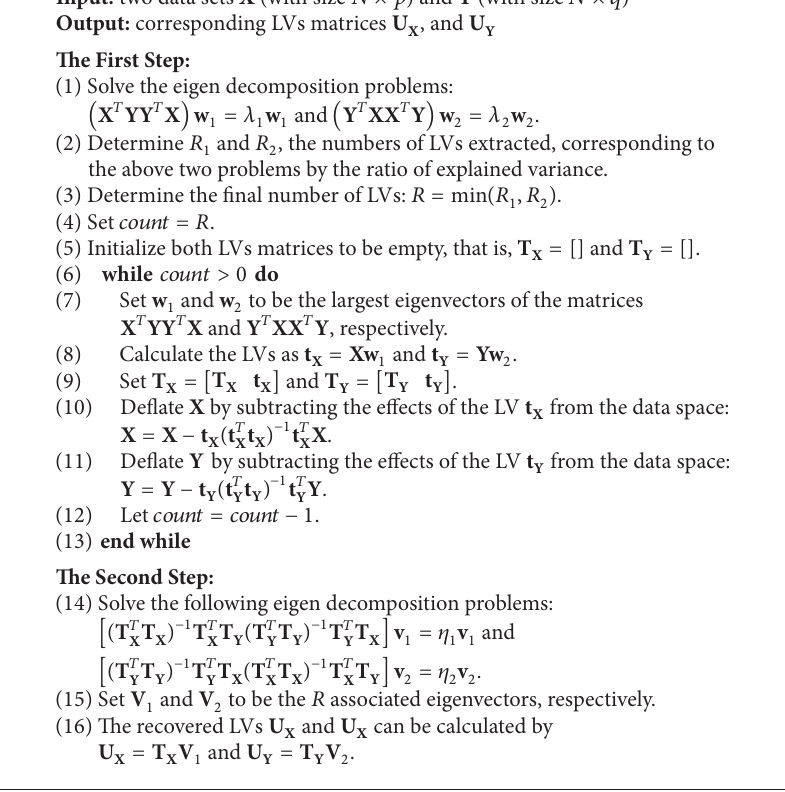
Algorithm 1: The combined PLS + CCA method.